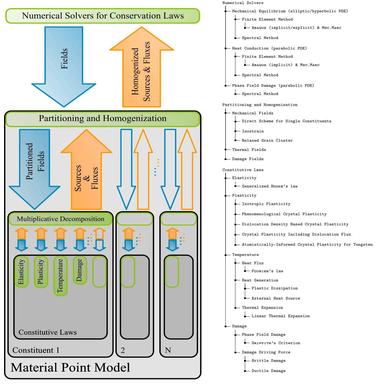
Concept of DAMASK. Each material point, which is part of a discretized body on which conservation laws are solved, is made up of multiple constituents that comprise of various constitutive laws.